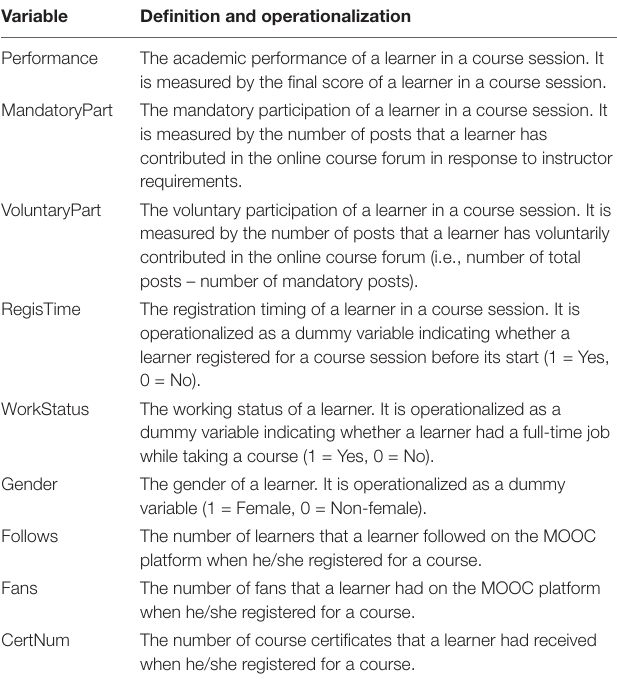
TABLE 1 | Variable definitions and